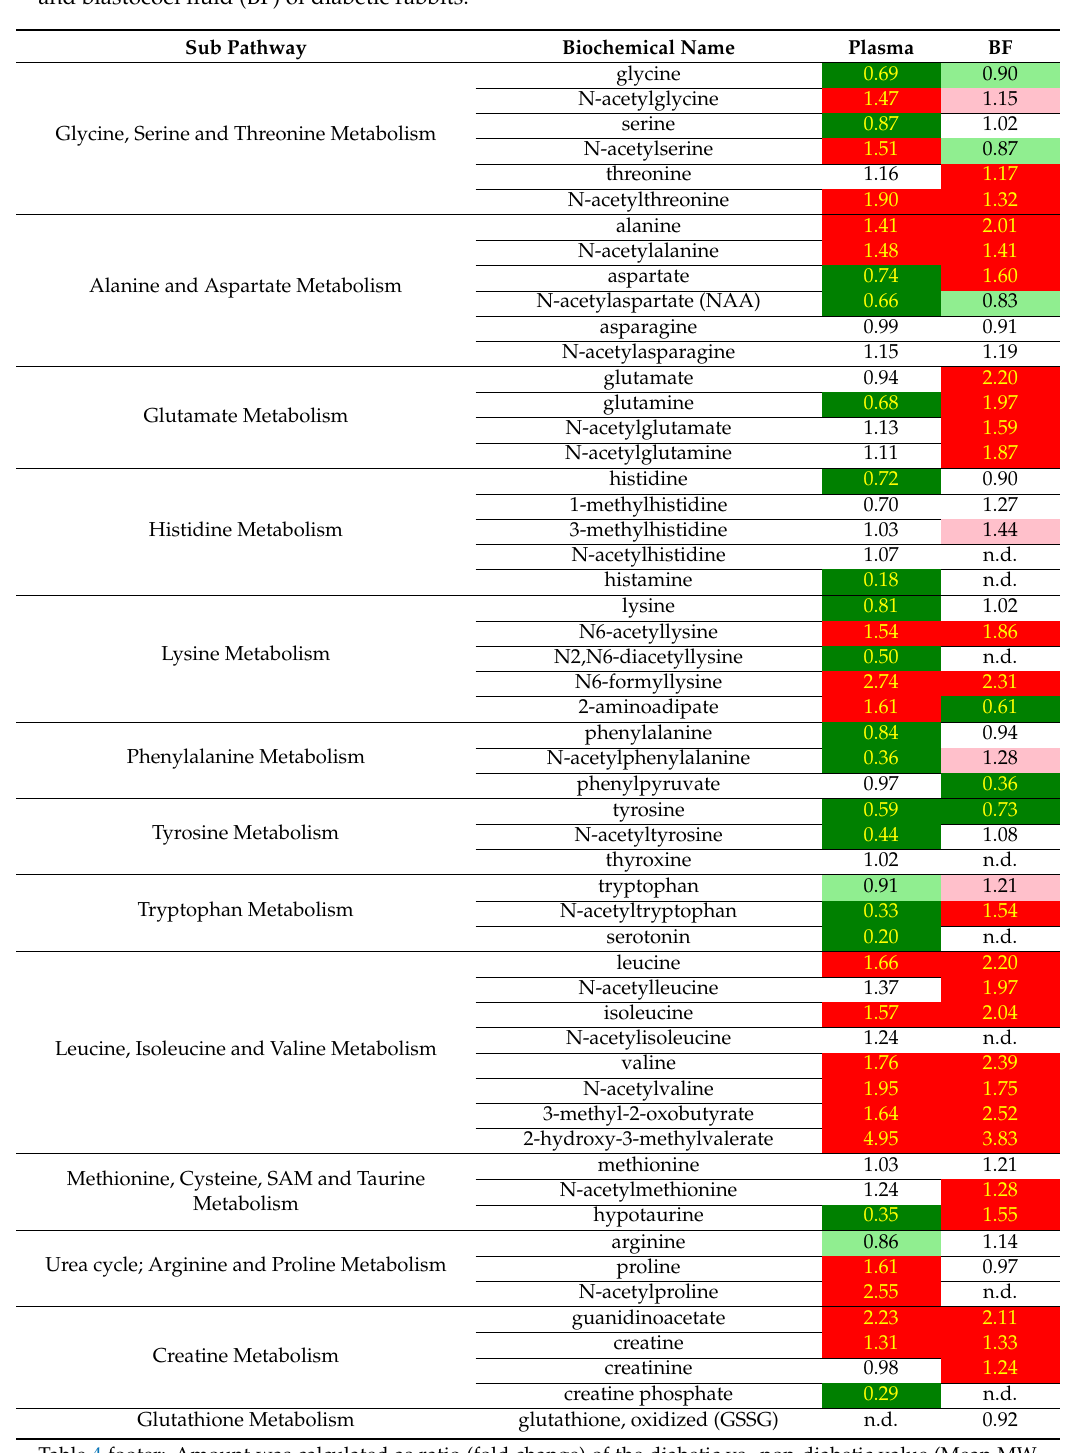
Table 4. Relative amounts of selected amino acids and peptides that were detected in maternal plasma and blastocoel fluid (BF) of diabetic rabbits.